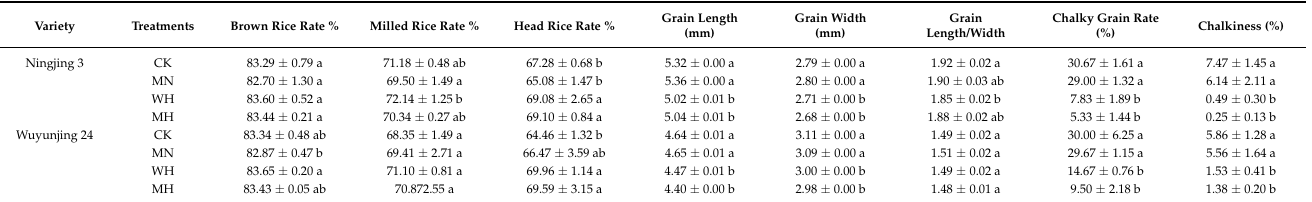
Table 3. Effects of exogenous MeJA on rice milling and appearance quality under high